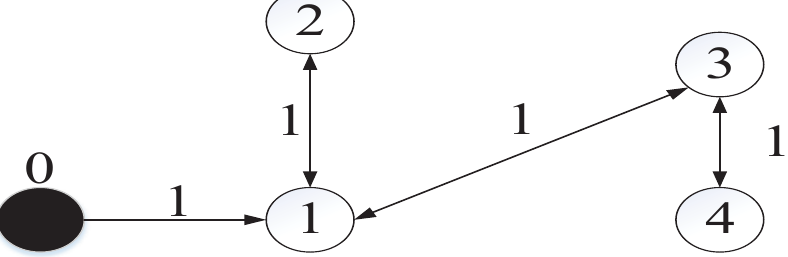
Figure 1. Topology structural diagram of the interaction between motors.